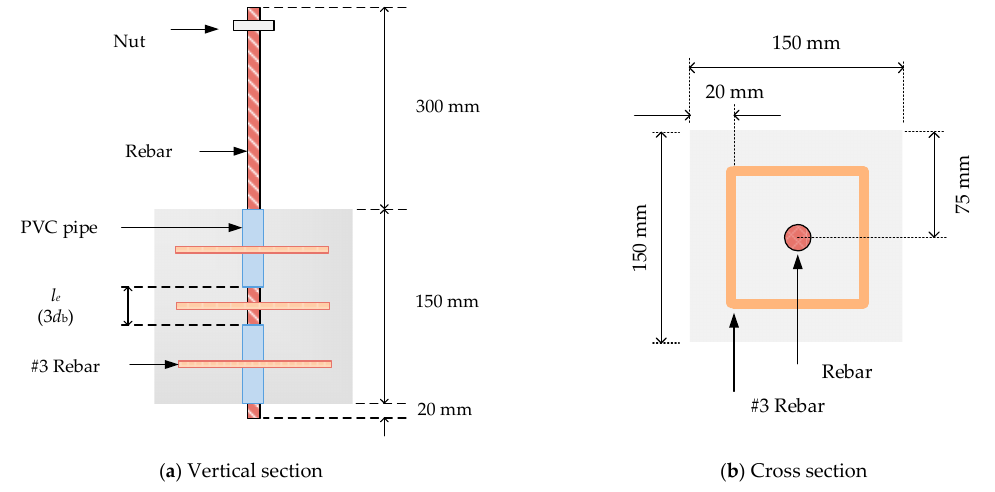
Figure 3. Dimensions and cross-sections of specimen: ( a ) Vertical section ; ( b ) Cross section .